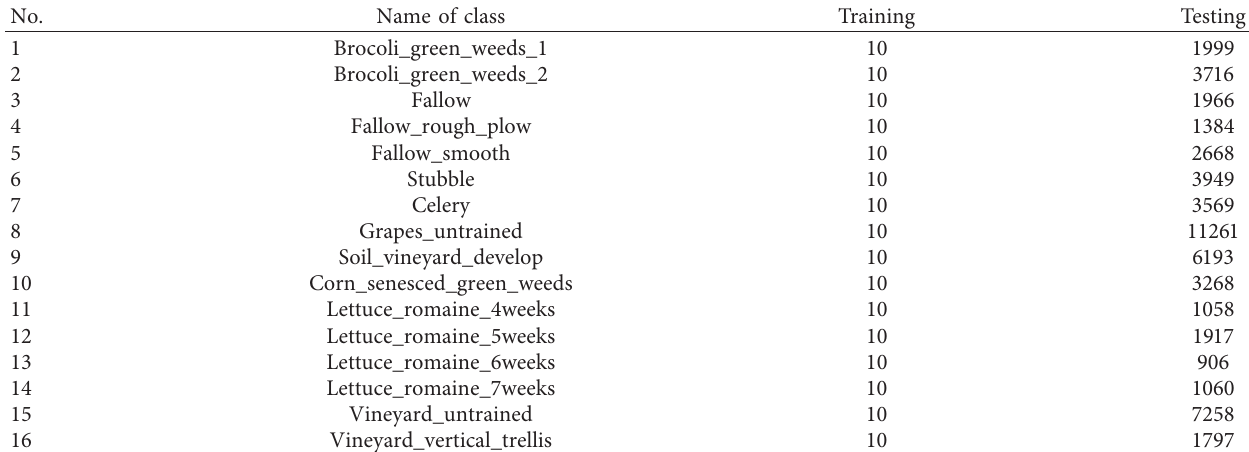
Table 4: The ground truth classes and their respective training and testing numbers of the Salinas datasets.